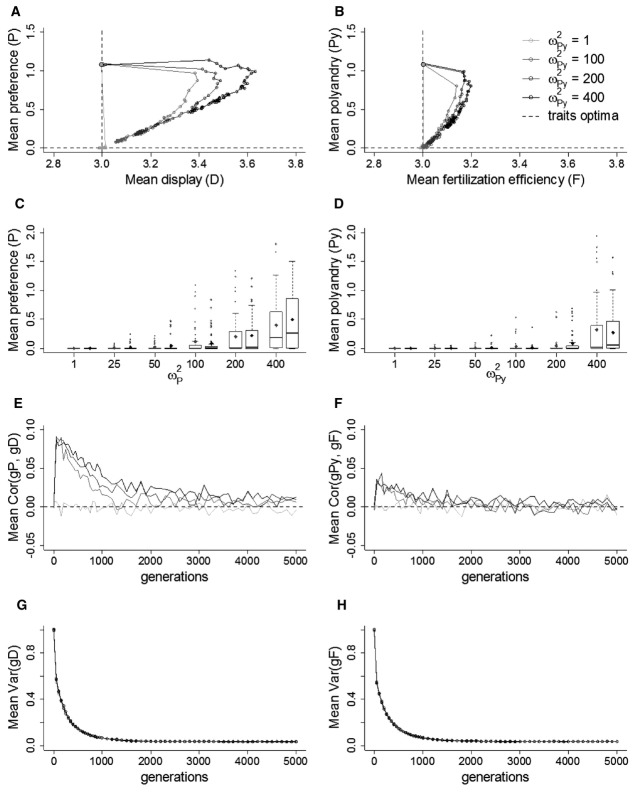
Coevolution of preference (P) and display (D; A, C, E, G), and of polyandry (Py) and fertilization efficiency (F; B, D, F, H), for selected costs. (A and B) Mean values for (A) P and D, and (B) Py and F for different strengths of direct selection on the female traits (ω2P and ω2Py). Gray circles indicate the simulation starting values. Dashed lines indicate the traits’ optima. (C and D) Phenotypic values of P and Py (white boxes) and neutral traits subject to the same strength of direct selection (gray boxes) at generation 5000, described as medians (solid bands), first and third quartiles (box limits), approximately twice the standard deviation (whiskers), and means (diamonds). (E and F) Mean genetic correlation between preference, gP, and display, gD [Cor(gP,gD)]; and between polyandry gPy, and fertilization efficiency, gF [Cor(gPy,gF); color codes as in (A and B)]. Dashed lines demarcate zero correlation. (G and H) Mean genotypic variance in D and F. All values are averaged over 50 replicates and plotted every 50 generations until generation 1000 and every 100 generations thereafter.